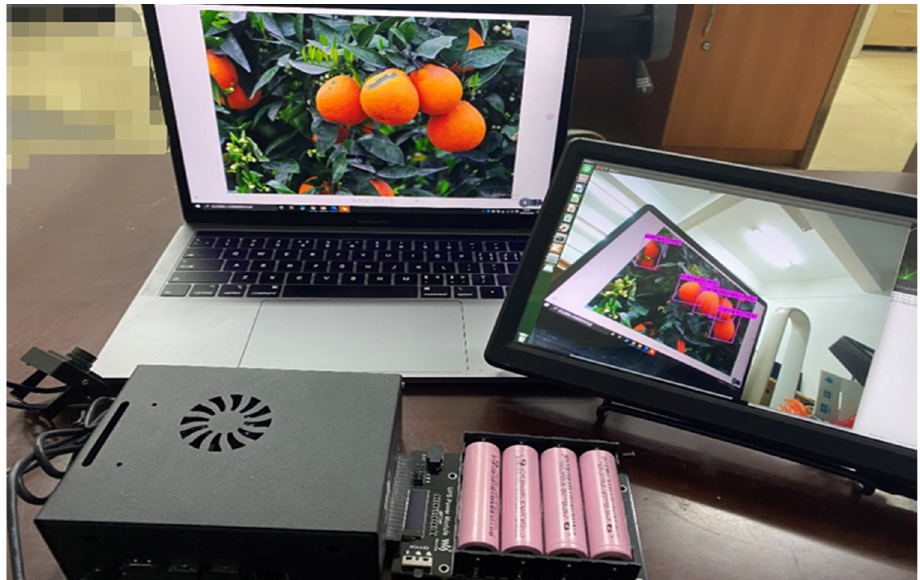
Figure 3. Portable edge computing device with a small visual display, mobile power supply, camera, Jetson nano, and internal target detection model.